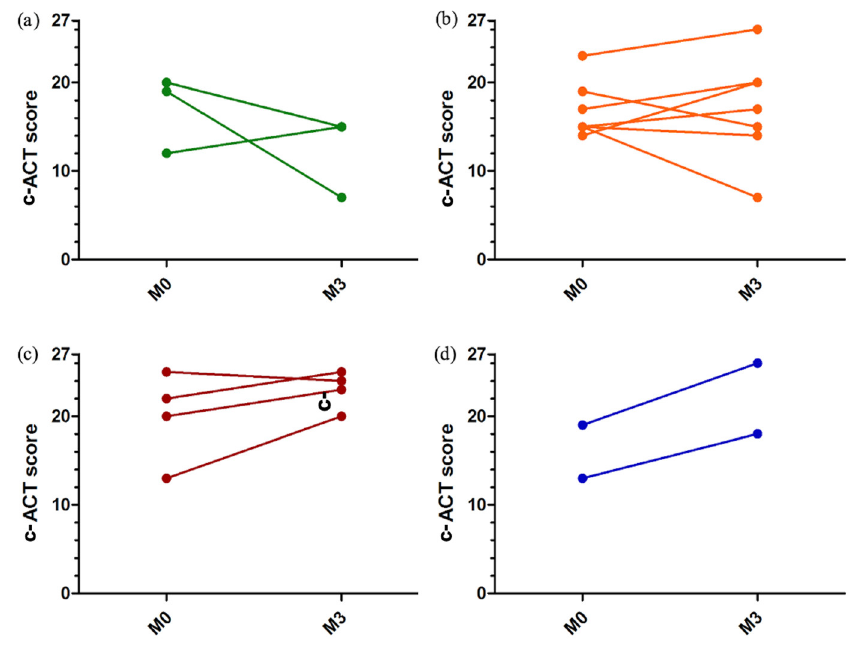
Figure 6. c-ACT (childhood Asthma Control Test) score at the beginning (M0) and at the end (M3) of the study according to the perception profile. Each line represents one patient. ( a ) good perceivers; ( b ) anarchic perceivers; ( c ) poor perceivers; ( d ) excessive perceivers. The c-ACT score varies between 0 (worst score) and 27 (best score). Score ≥ 20 indicates good asthma control .